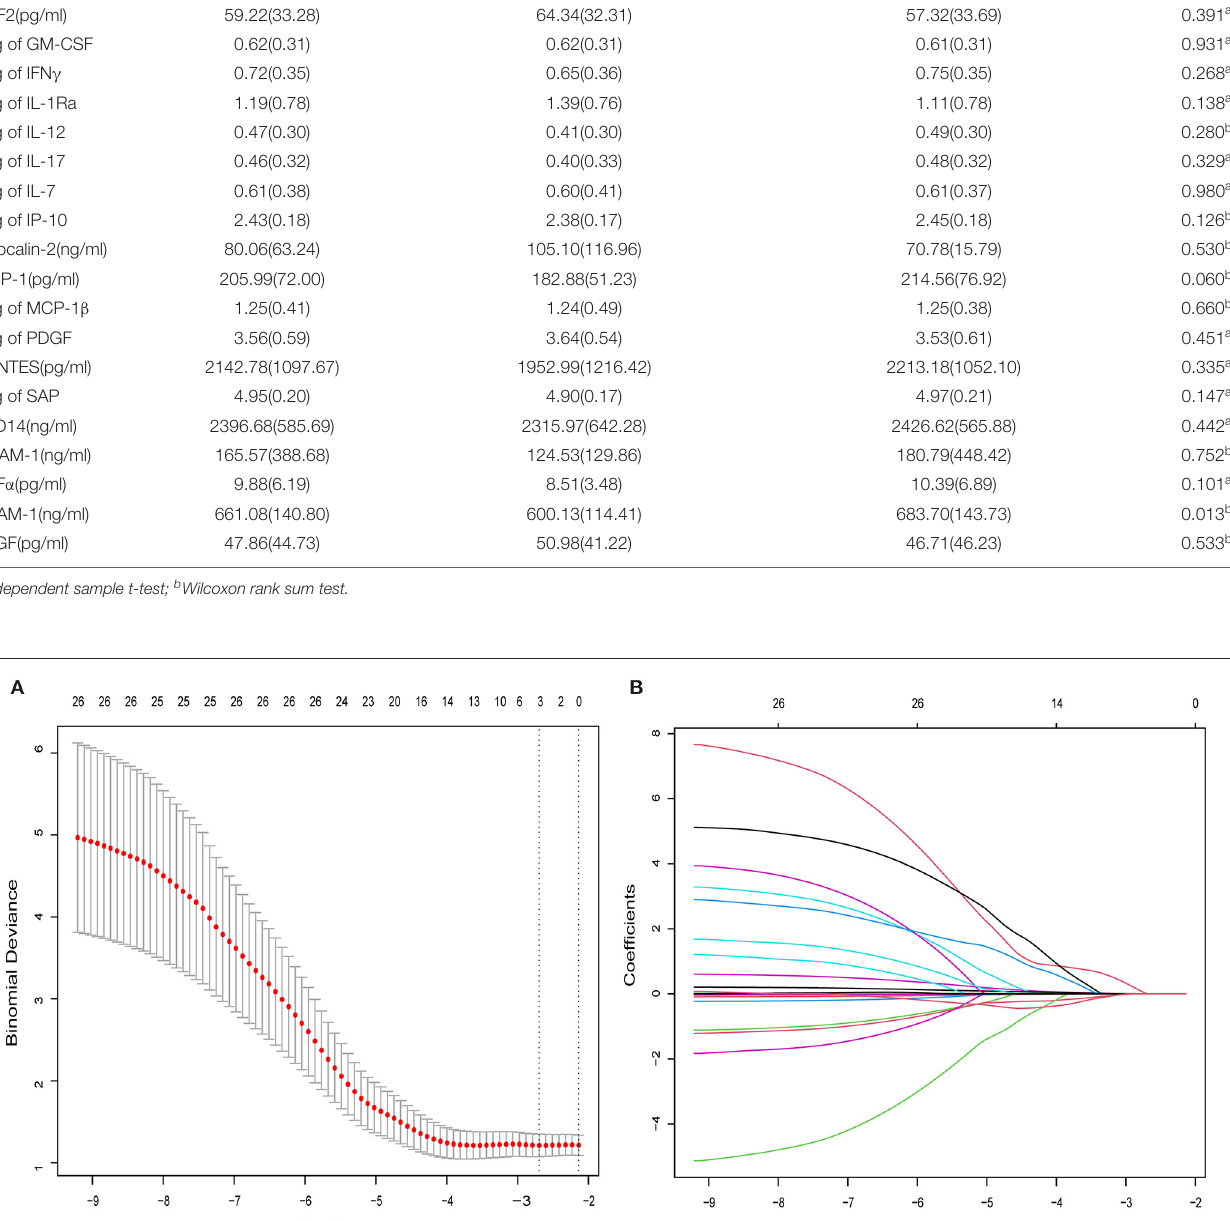
Frontiers in Psychiatry |